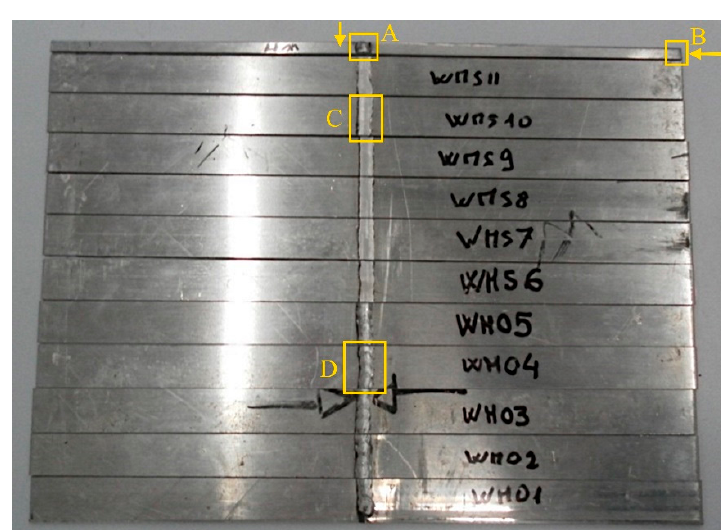
Figure 2. Drawing of micro-hardness measures path (red-diamond) along with BM, HAZ and WM and near the edges. Representation of the weld in the protruded and in the milled state.